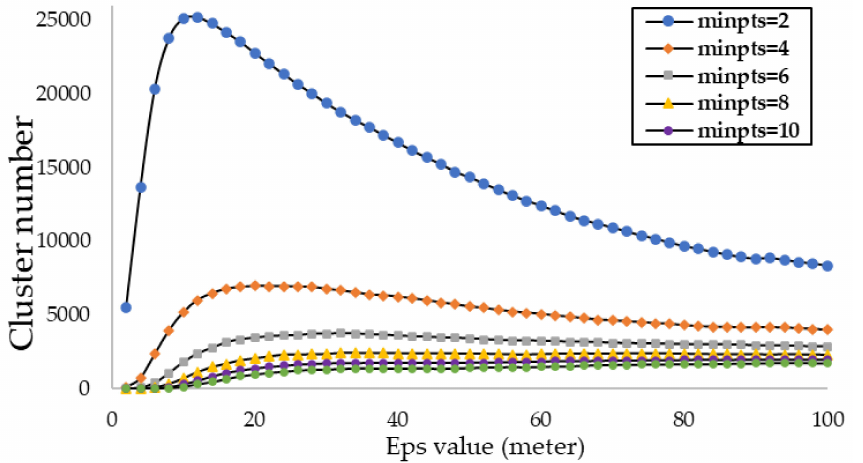
Figure 3. Cluster numbers under different parameters.